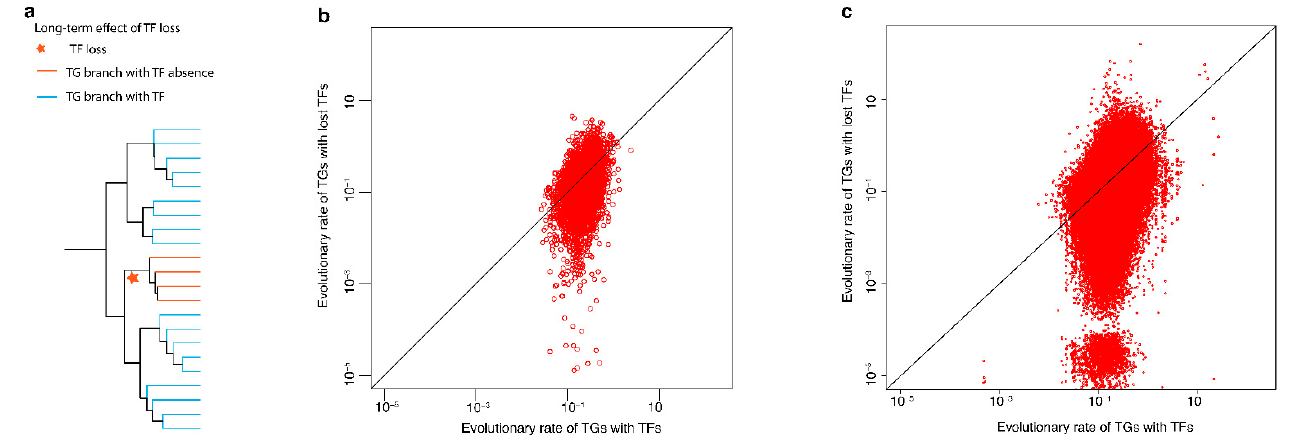
Figure 5. Deceleratory effect of the loss of transcription factors (TFs) on molecular evolutionary rates of their target genes (TGs). With decreased molecular evolutionary rate, current genes survive till present. ( a ) Comparison of the evolutionary rates of TGs in species in the subtree of the TF event (colored in red) with the rates of TGs in other species. ( b , c ) Long-term effect of TF loss on the evolutionary rate of TGs, TF-TG interactions by ( b ) literature curations or ( c ) based on Chip-seq data. x -axis: evolutionary rate of TGs still controlled by TFs; y -axis: evolutionary rate of TGs with lost TFs. TF-TG interactions by literature curations from TTRUST2 database; TF-TG interactions based on Chip-seq data from the hTFtarget database.